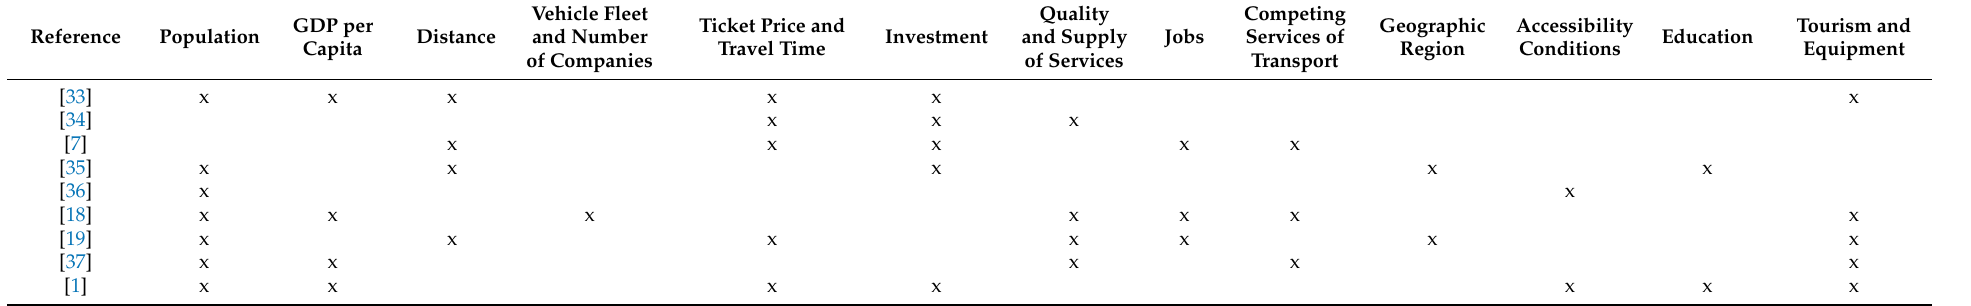
Table 1. Criteria for regional airport investments and their respective